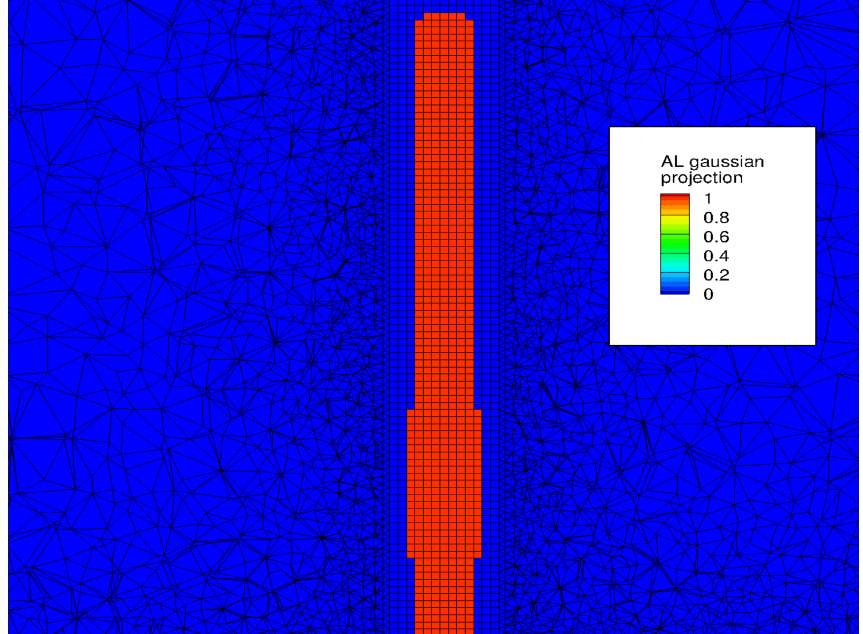
Figure 5. Periodic grid. Gaussian projection of aerodynamic forces.